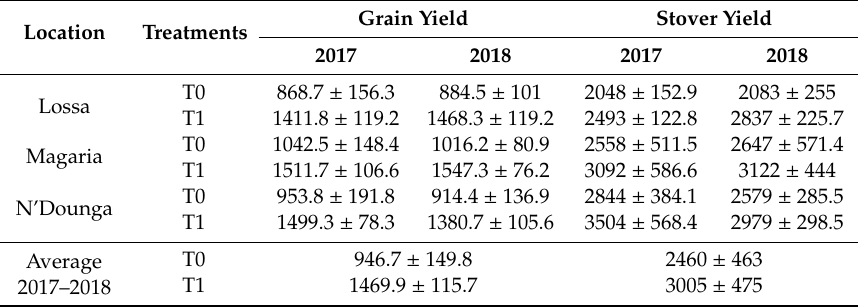
Table 3. E ff ect of treatments on grain and stover yield (kg ha − 1 ). Probabilities of main e ff ects and interactions